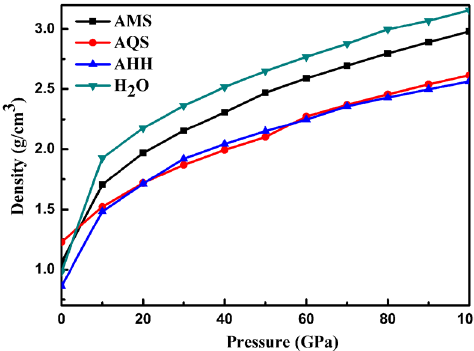
Fig. 3 Gravimetric densities of various icy mixtures as function of pressure. Mass densities up to 100 GPa for best crystal structures of 1:1- H 2 S-NH 3 (AMS), 1:4-H 2 S-NH 3 (AQS), 1:2-H 2 O-NH 3 (AHH), and pure ice